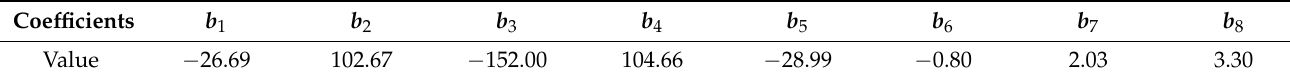
Figure 3. Current data of battery experiments. Table 1. OCV–SOC fitting function